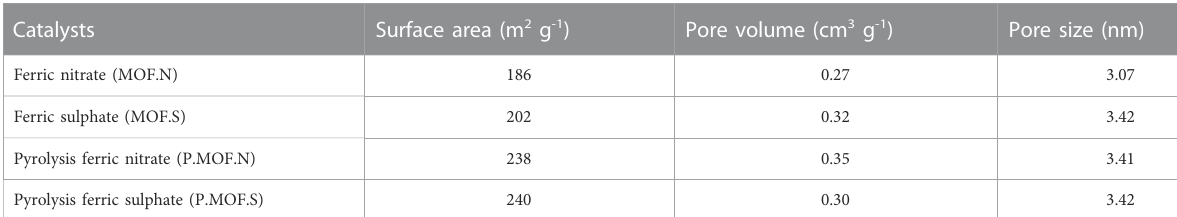
TABLE 1 N2- Physiosorption analysis of MOFs catalysts.